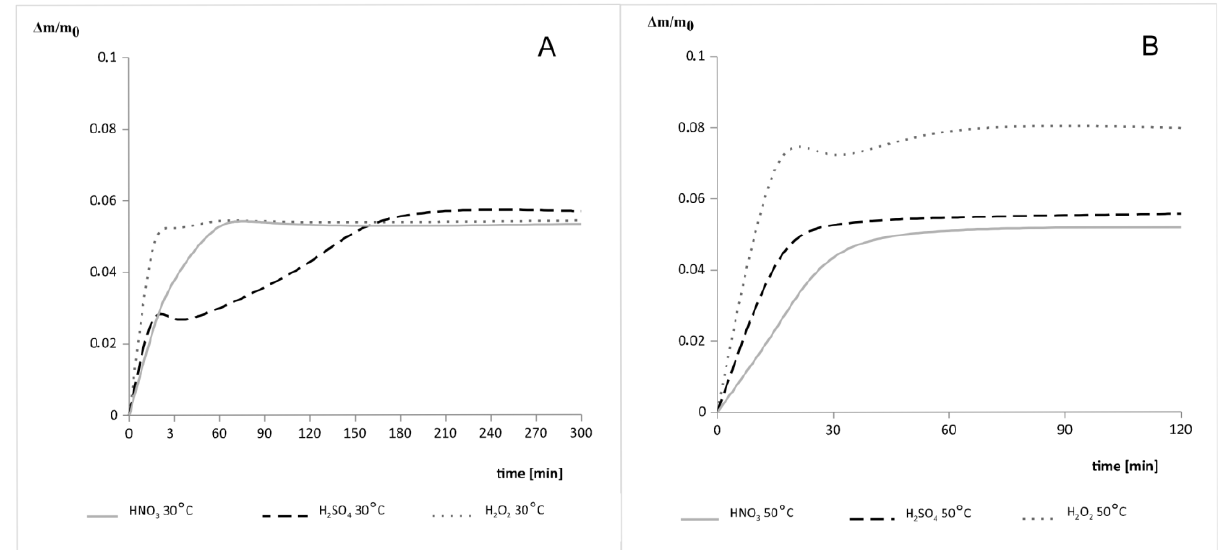
Figure 2. Etching results for samples of the milled thin-film module made of CdTe in 1 M H 2 SO 4 , 3 M HNO 3 , and 30% H 2 O 2 at ( A ) 30 °C and ( B ) 50 °C.